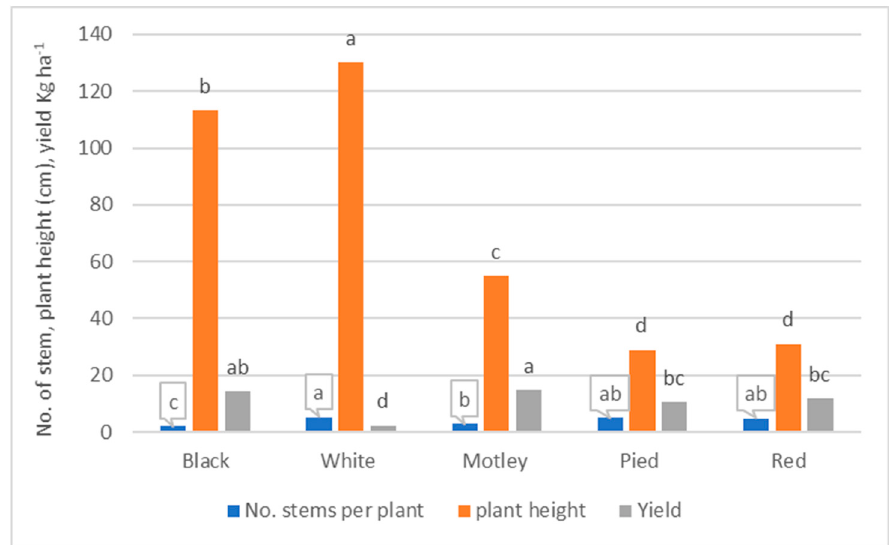
Figure 6. Mean comparison for number of stems per plant, plant height (cm), and grain yield (kg